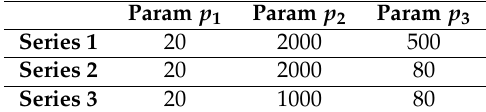
Table 4. Parameters selection fo the different series in the graph.